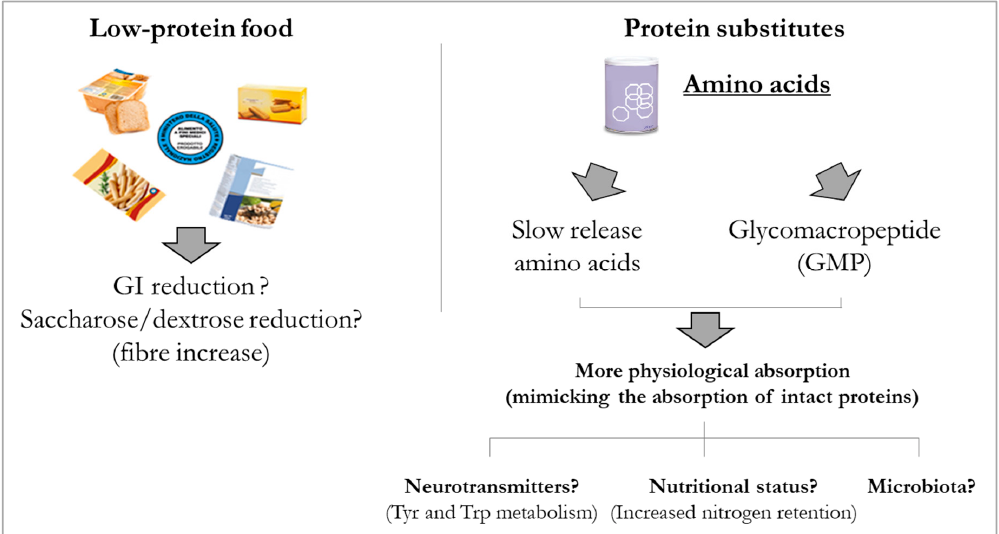
Figure 3. Modulation of dietary approach in PKU. The provision of low-protein foods that are balanced in their content and the quality of carbohydrates may favour patients with PKU in better controlling the composition of the microbiota and as a consequence the host metabolism connected to microbial metabolic processes. Phe-free AAs are the mainstay of the dietary approach to PKU and their integration in a dietary regimen poor of natural proteins needed to reduce the intake of Phe is key to patient wellbeing. New options with AAs deriving from natural sources or specifically engineered to provide absorption features closer to intact proteins are available for patients with PKU. A di ff erent way of administering AAs could prove favourable for patient with PKU by modulating some of the imbalances typical of the PKU